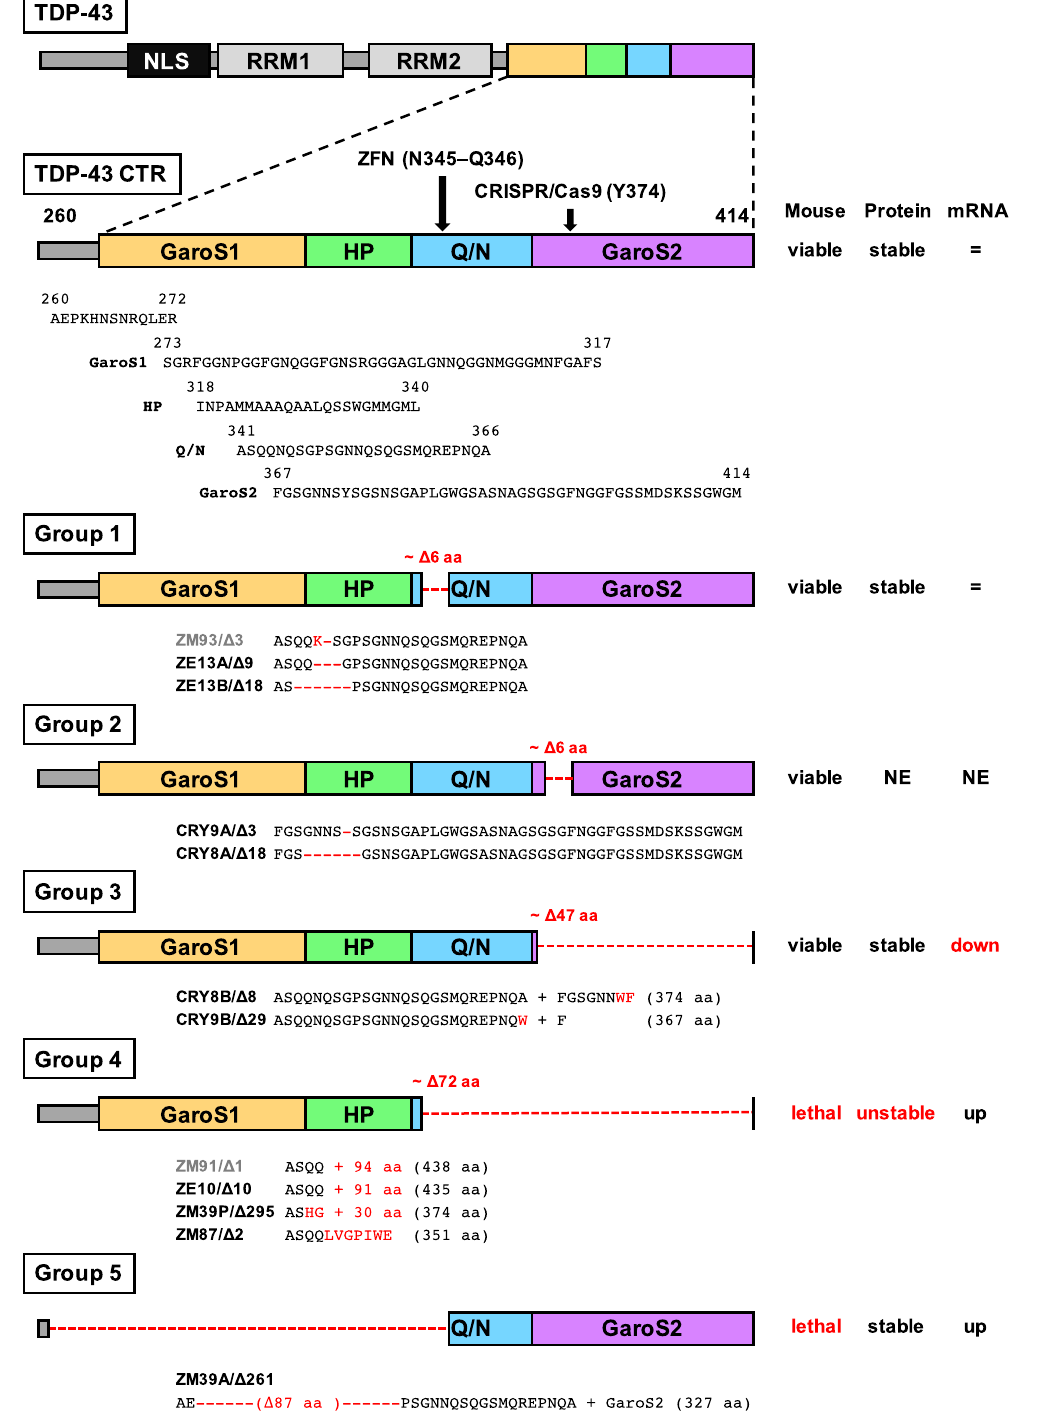
Figure 1. Schematic diagram of mouse TDP-43 and putative protein structures with various CTR deletions. TDP-43 contains 414 aa residues and consists of a bipartite nuclear localization signal (NLS), two RNA recognition motifs (RRM), and a long-disordered CTR. CTR is divided into four sub-regions, the GaroS1 (yellow), HP (green), Q/N-rich (blue), and GaroS2 segments (purple); the aa sequences are depicted by one-letter codes according to the TDP-43 CTR. The genome-edited mice were categorized into five groups based on the putative CTR structures. Each deleted region is drawn as a red dotted line. The putative aa sequence in each mouse line is shown in black and red letters indicating WT and substituted aa residues, respectively. The gaps in the aa sequences are represented as red dashes. The characteristics of each group determined in this study are shown on the right. Mouse, embryonic lethality of homozygous mice. Protein, protein stability in the eight-week- old mouse cerebrum. mRNA, total expression level of the Tardbp mRNA. NE, not examined. Note that the putative protein structures of ZM93/Δ3 and ZM91/Δ1 mice (gray) are similar to those of ZM13A/Δ9 and ZE10/Δ10, respectively, and were not used in this